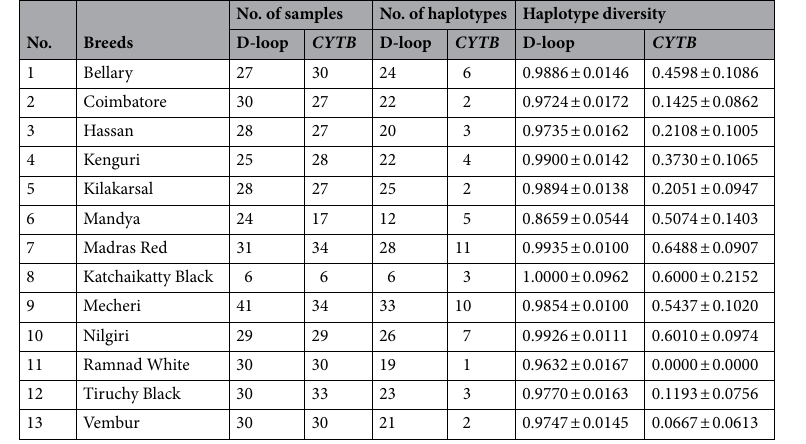
Table 1. Genetic diversity indices of south Indian sheep